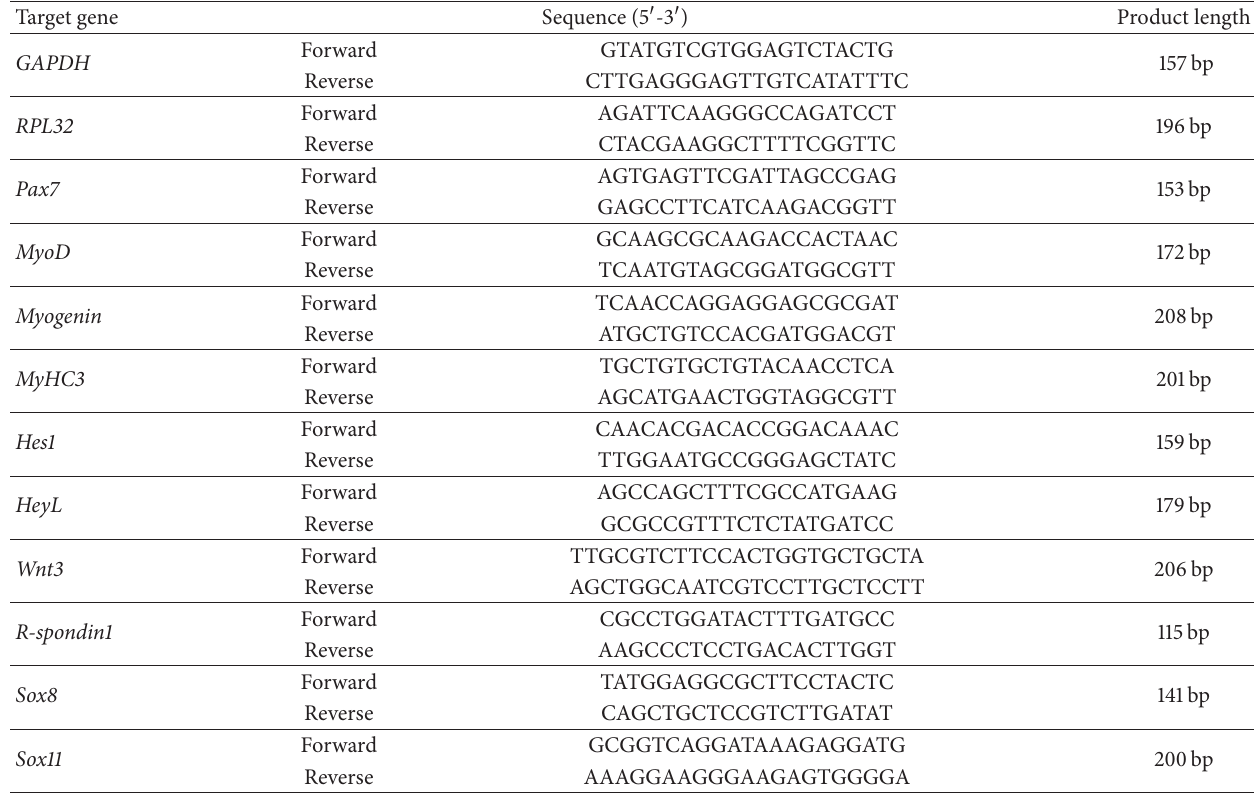
Table 1: Primer sequences for